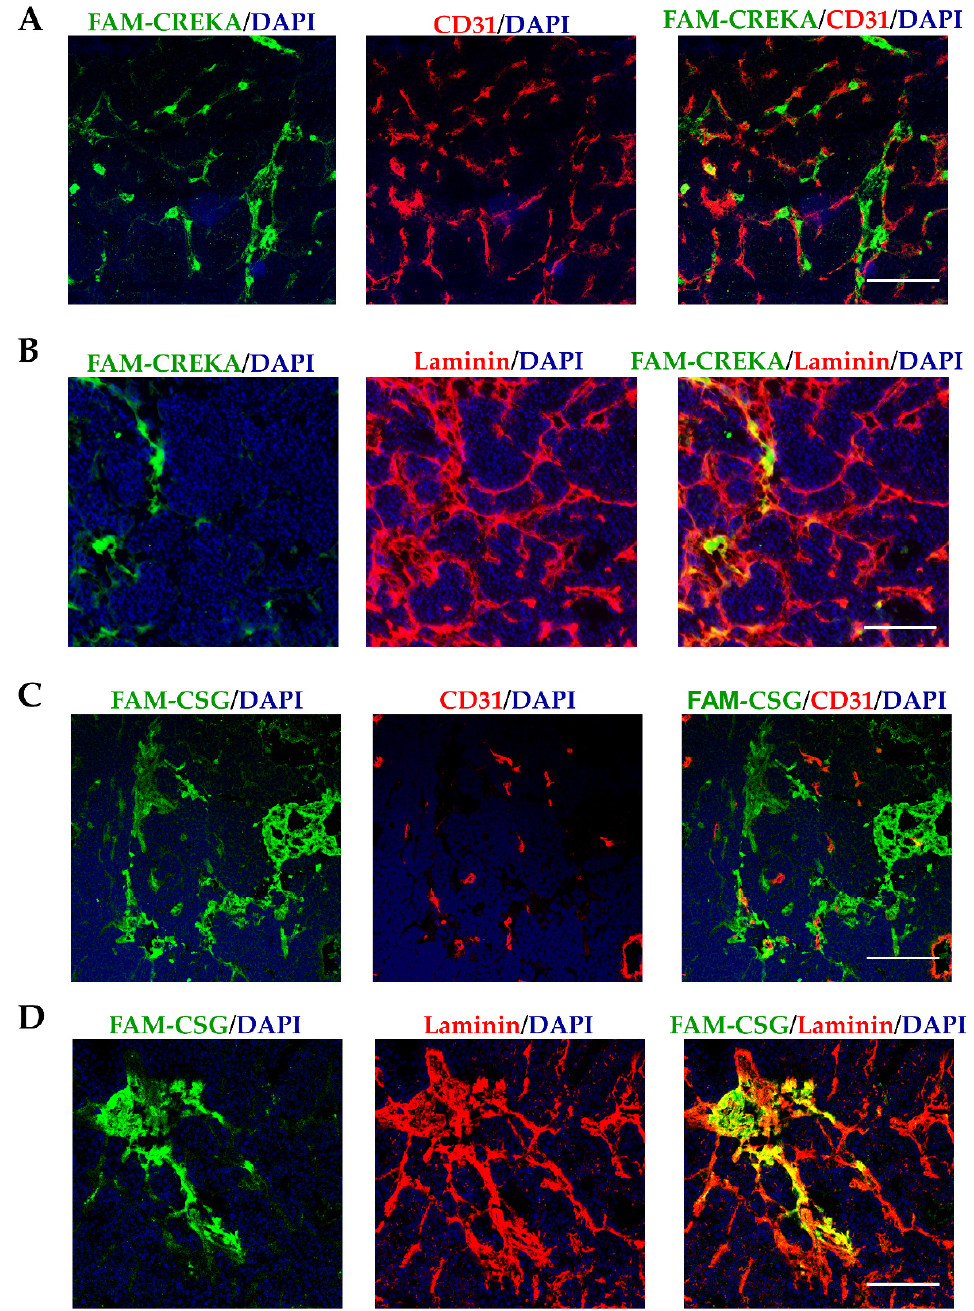
Figure 1. CSG and CREKA specifically recognise different compartments in RIP1-Tag5 tumours. Tumour-bearing RIP1-Tag5 mice were i.v. injected with 0.1 µ mol of FAM-CREKA or FAM-CSG, and tissues were collected after 1 h of circulation. ( A – D ) show distribution of FAM-CREKA and FAM-CSG (green) in tumours co-stained either with the vascular marker CD31 or the ECM marker laminin (red). Scale bars: 50 µm.